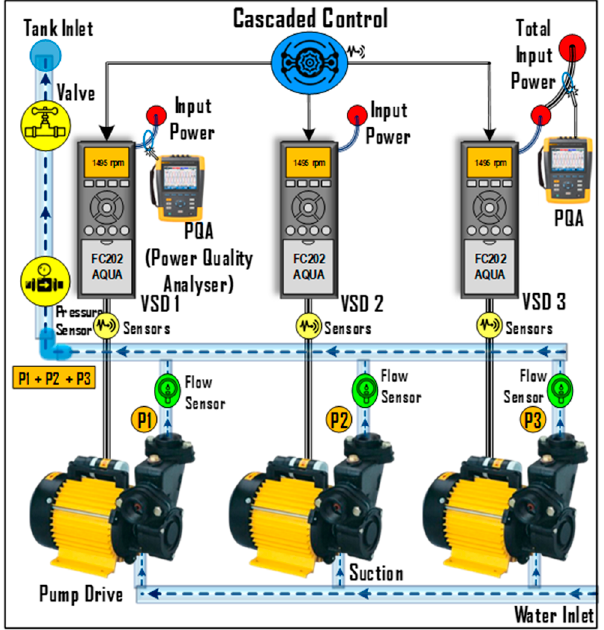
Figure 5. Parallel pump system.